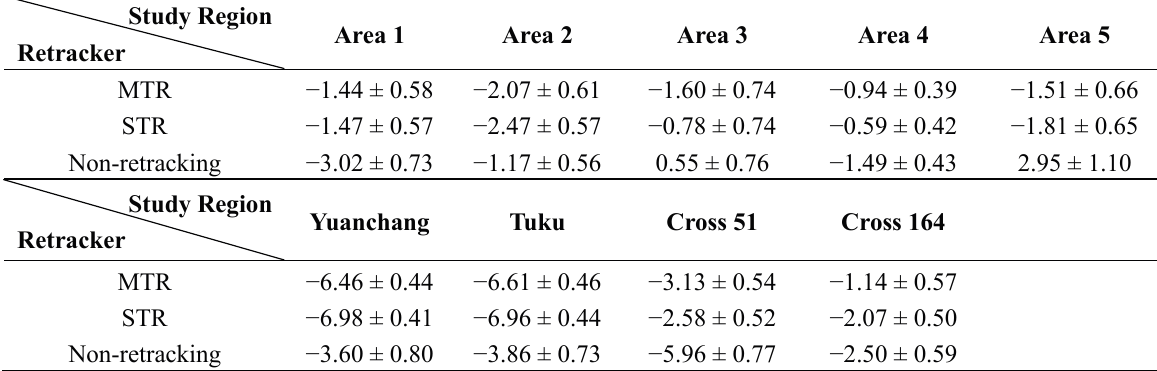
Figure 10. Time series of the LSAs in the nine study regions derived from satellite altimetry retracked by MTR and STR. Green oblique lines represent the land motion derived from the leveling-derived trend rates as shown in Figure 11. ( a ) area 1; ( b ) area 2; ( c ) area 3; ( d ) area 4; ( e ) area 5; ( f ) Yuanchang; ( g ) Tuku; ( h ) pass 51 in the crossover area; and ( i ) pass 164 in the crossover area. Table 2. Trends of LSAs from retracked altimetry data in the nine study regions (unit: cm/yr). Study